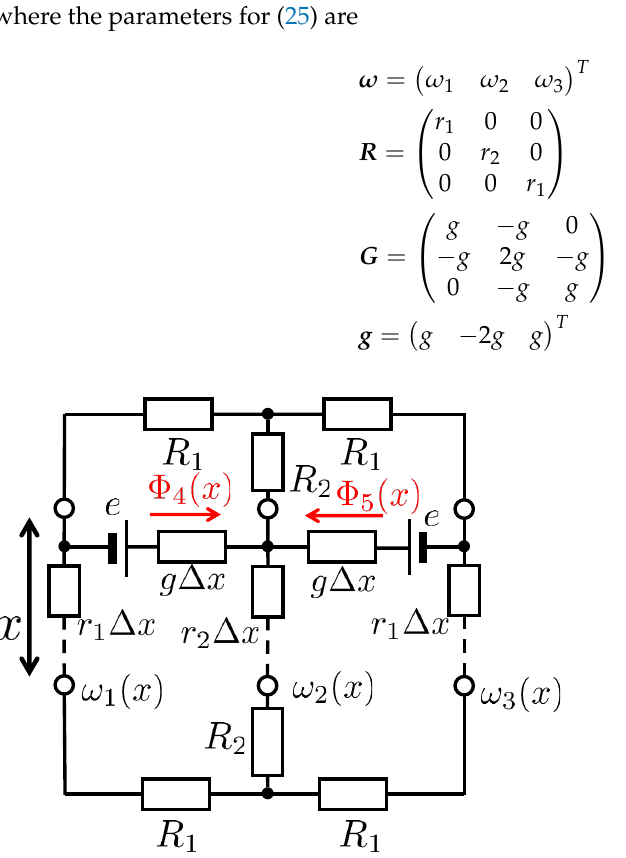
Figure 8. Magnetic circuit model of